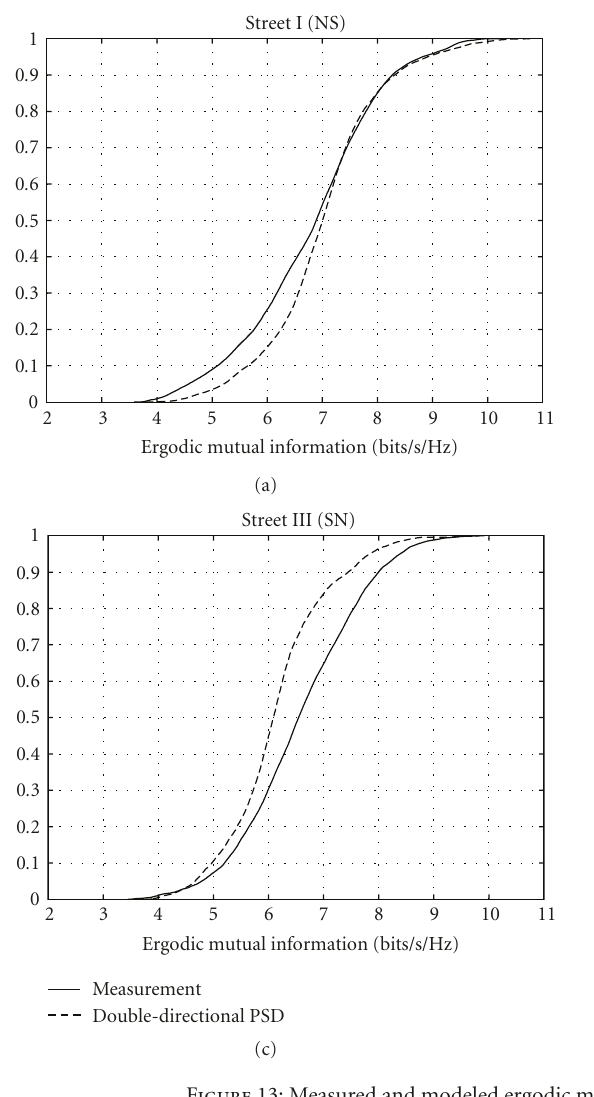
Figure 13: Measured and modeled ergodic mutual information for the Laptop scenario.